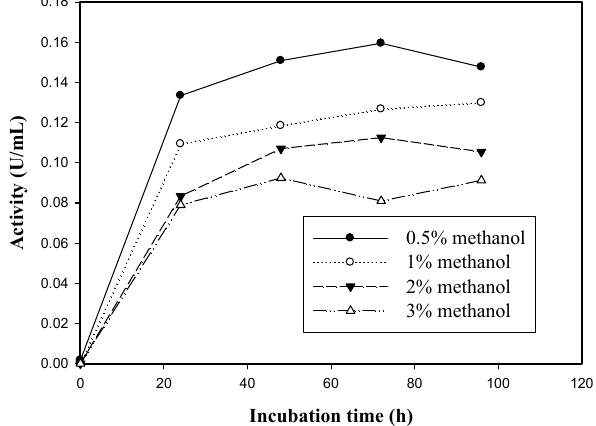
Figure 2. Strain 31 was induced with different concentrations (0.5, 1, 2, and 3%) of